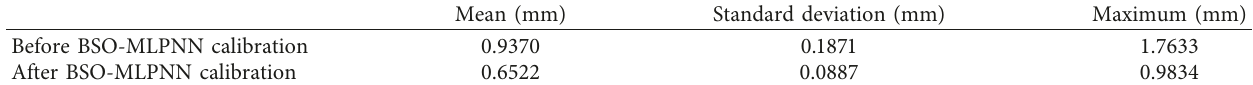
Table 9: Absolute positioning accuracy of the SIASUN SR210D manipulator of validation